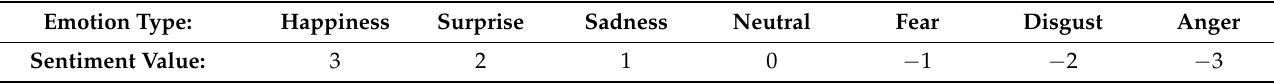
Table 2. Sentiment values used for the labelling process by the sentiment analyzer used in AthPPA. Emotion Type: